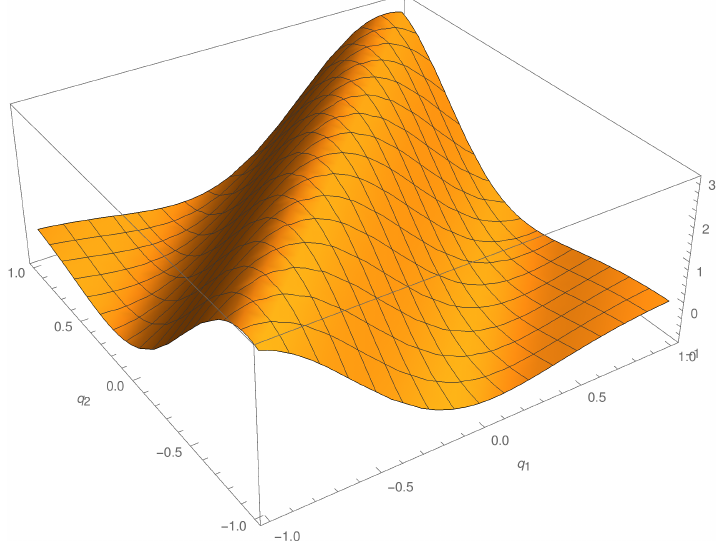
Figure 5. Wigner distribution (110) for the state (108). The most striking property of this W can be negative. We have used p 1 = p 2 = 0 and q 0 = 0.1 and have plotted √ π W